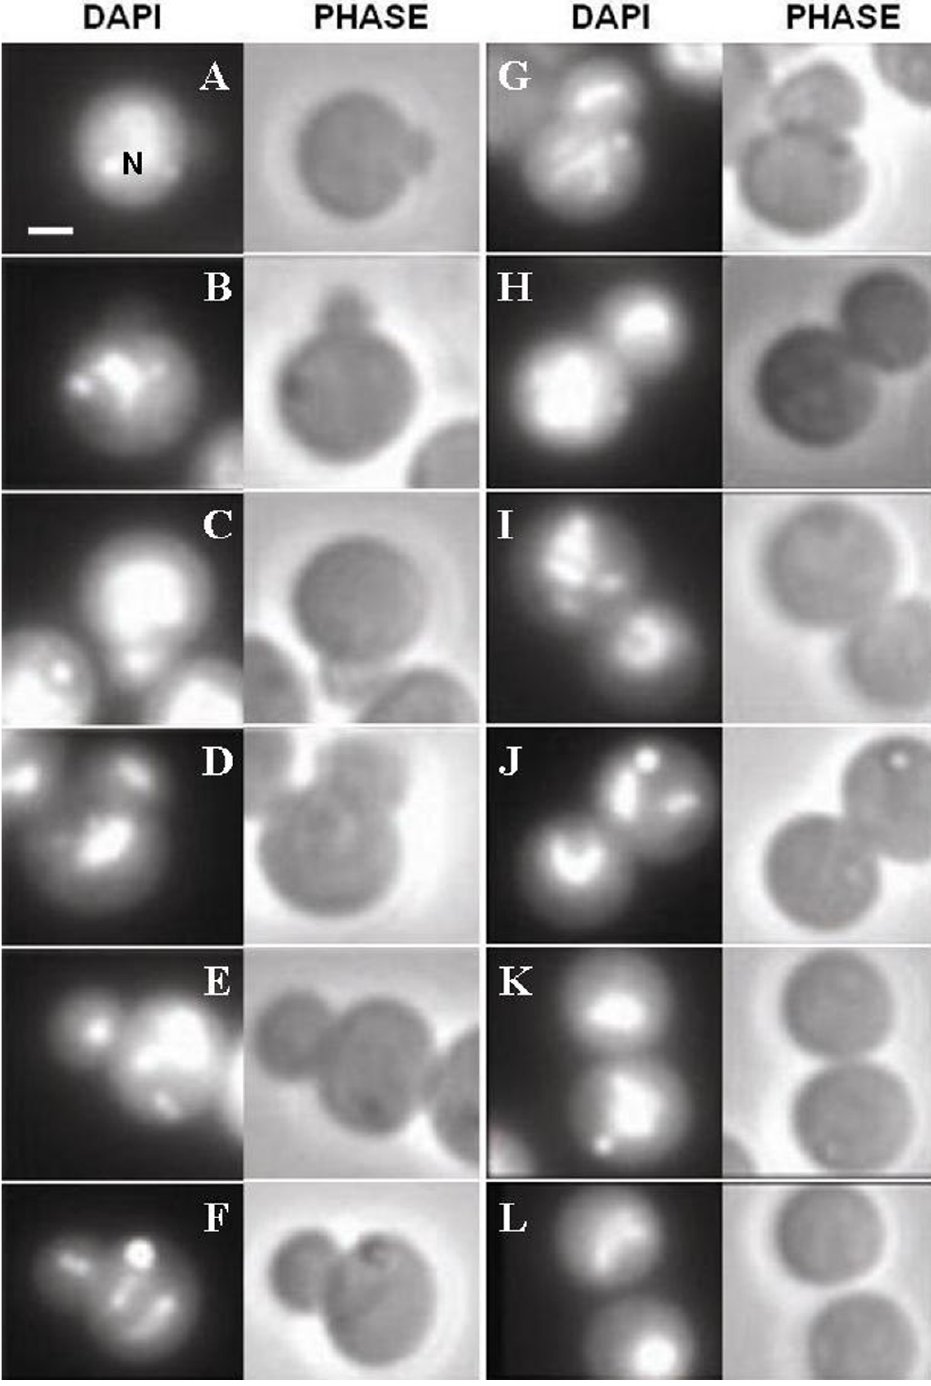
Figure 2 Fluorescence and phase contrast micrographs of individual G. obscuriglobus budding cells . Each pair of micro- graphs (DAPI and PHASE) represents a different budding stage seen after staining with DAPI and visualizing via fluorescence and phase contrast microscopy, and each letter A-L refers to a paired micrograph (DAPI-stained on the left and PHASE micro- scopy on the right) of a different cell in each case. Nucleoid (N) DNA is stained with DAPI. Pair A represents the earliest bud- ding stage while pair L represents the final stage. Bar – 1 μ